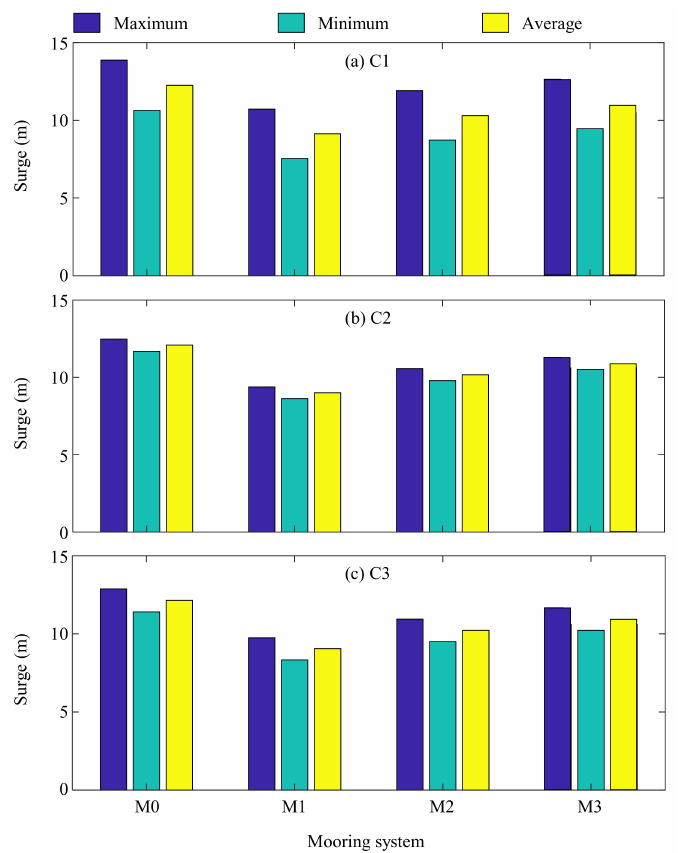
Figure 7. Maximum, minimum, and average values of wind turbine surge movement time series with M0–3 when under: ( a ) C1; ( b ) C2; ( c )